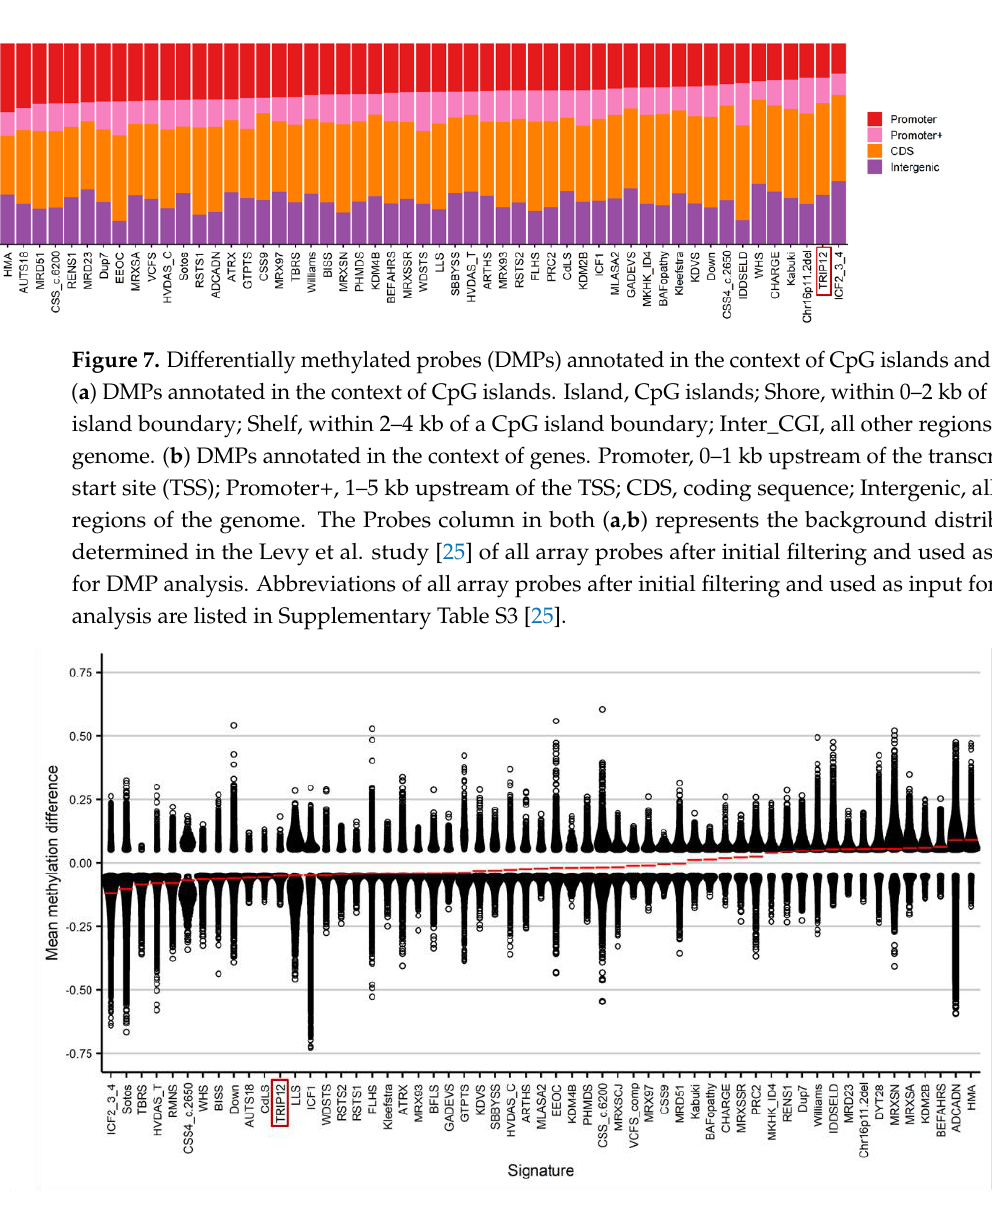
Figure 8. Relationships between the TRIP12 cohort and 56 other EpiSign™ disorders : ( a ) Methyla- tion differences of all differentially methylated probes (DMPs) for each cohort, sorted by mean methylation. Each circle represents one probe. Red lines indicate mean methylation; ( b ) Tree and leaf visualization of Euclidean clustering of all 57 cohorts using the top n DMPs for each group, where n = min (# of DMPs, 500). Cohort samples were aggregated using the median value of each probe within a group. A leaf node represents a cohort, with node sizes illustrating relative scales of the number of selected DMPs for the corresponding cohort, and node colors are indicative of the global mean methylation difference. Abbreviations are listed in Supplementary Table S3.